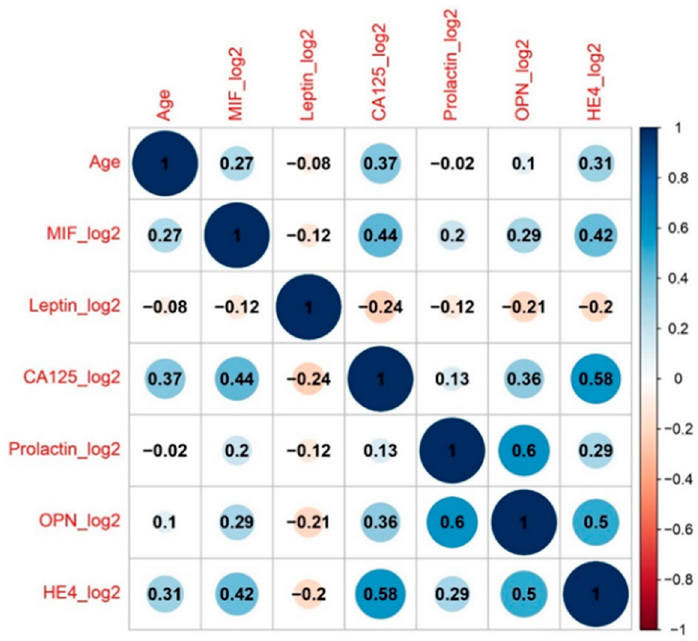
Figure A2. Correlation structure of all predictors.